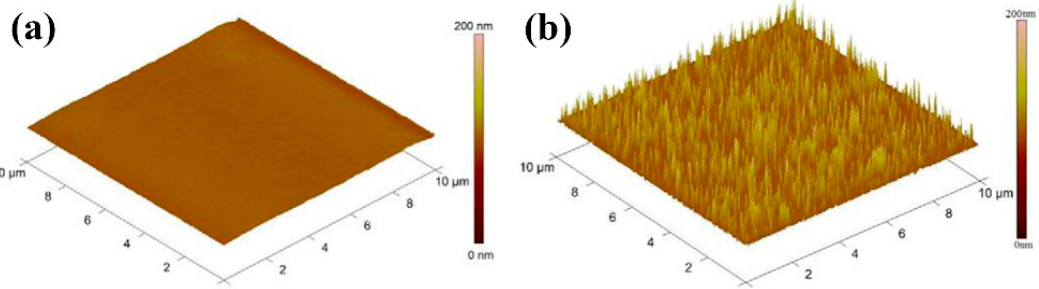
Figure 21. AFM images of the ( a ) unmodified glassy carbon electrode and ( b ) poly Nile blue modified glassy carbon electrode. Modified with permission from [231]. Copyright 2016 Elsevier.